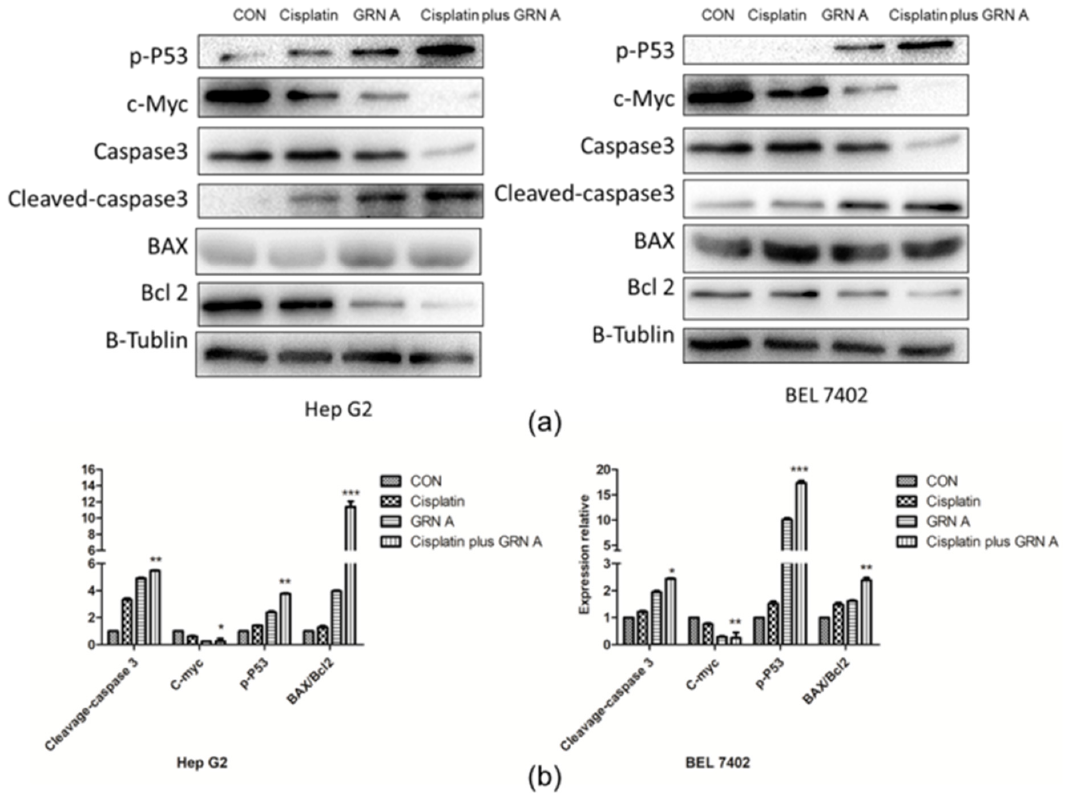
Figure 4. Effects of cisplatin, GRN A, and the combination of the two drugs on the expression of apoptotic related-proteins. ( a ) Western blot analysis. Cells were treated with cisplatin, GRN A, and the combination of the two drugs. The expression of some apoptotic genes, including BAX , Bcl-2 , c- Myc , caspase-3 , and phosphated-p53 , were determined by western blot, as described in the materials and methods section. ( b ) Quantitative results of gene expression. ( n ≥ 3, * p < 0.05, ** p < 0.01, *** p <